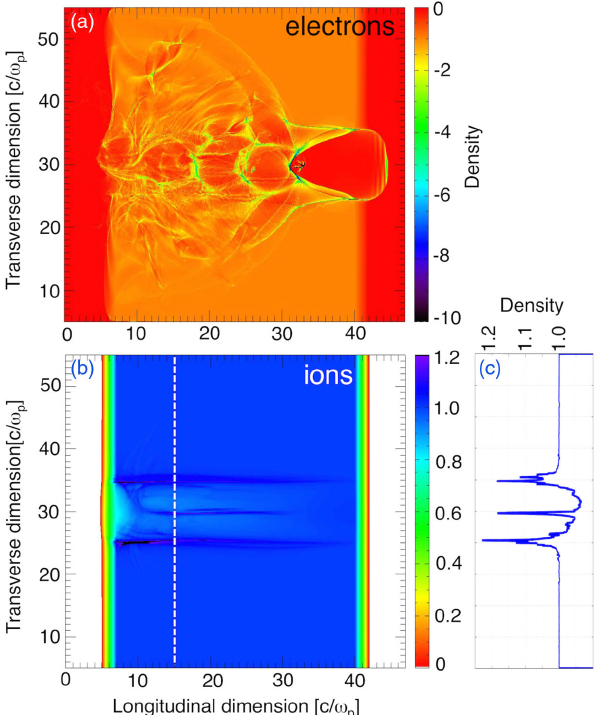
FIG. 1. Laser driven nonlinear ion wake at early time ¼ 0 . 17 f − 1 , where f is the plasma ion frequency) ( t ¼ 46 ω − 1 pe pi pi ¼ m ¼ 1836 m in m plasma. (a) Electron bubble mode in i p e ¼ 10 driven by a Cartesian coordinates (fixed box) with ω 0 ω pe matched laser pulse (vector potential a 0 ¼ 4 and frequency ω 0 ) ≃ 4 c . (b) Nonlinear ion wake in the form of a with R ω B pe cylindrical ion-soliton of radius ≃ 4 c excited behind the bubble ω pe electron wake in a proton plasma. (c) Transverse ion-density profile at z ¼ 15 c= ω . Notice that the ion density perturbation in pe this excitation phase is still building up and is a fraction of the < 1 . background ion density, δ n i n 0